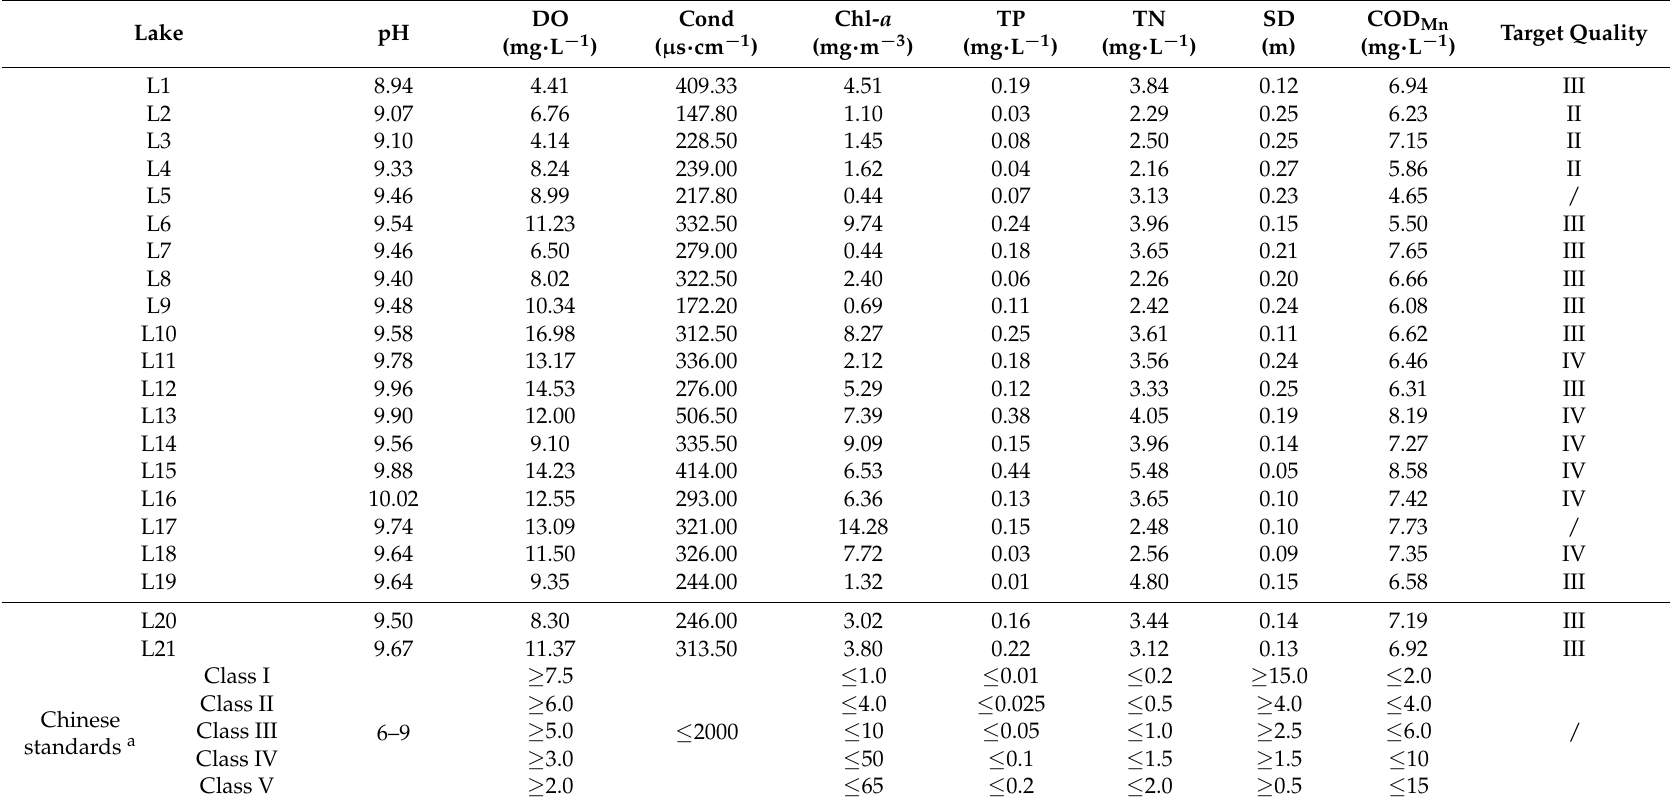
Table 3. Basic parameters and target water quality of 21 lakes in